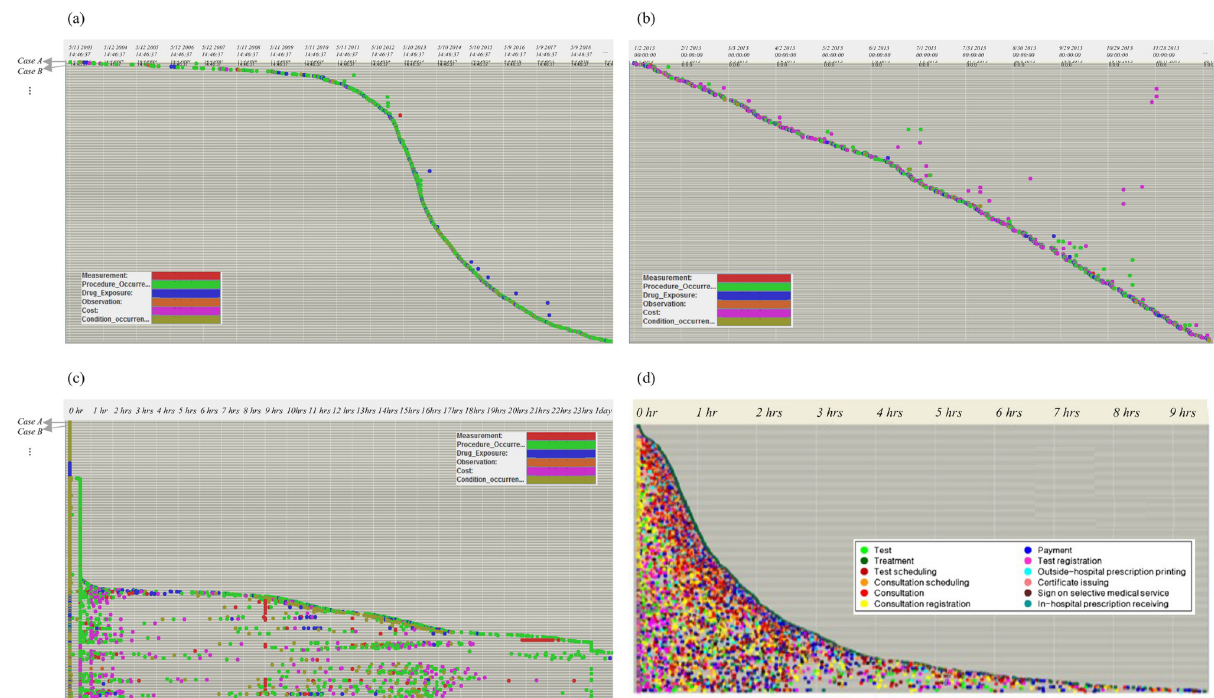
Fig 6. Dotted chart analysis. (a) dotted chart for all activities by case, occurred between 2003 and 2019; (b) dotted chart for activities by case, occurred in 2013; (c) dotted chart for all activities occurred by case, sorted by case duration; (d) dotted chart for all activities occurred by case, sorted by case duration, excerpted from